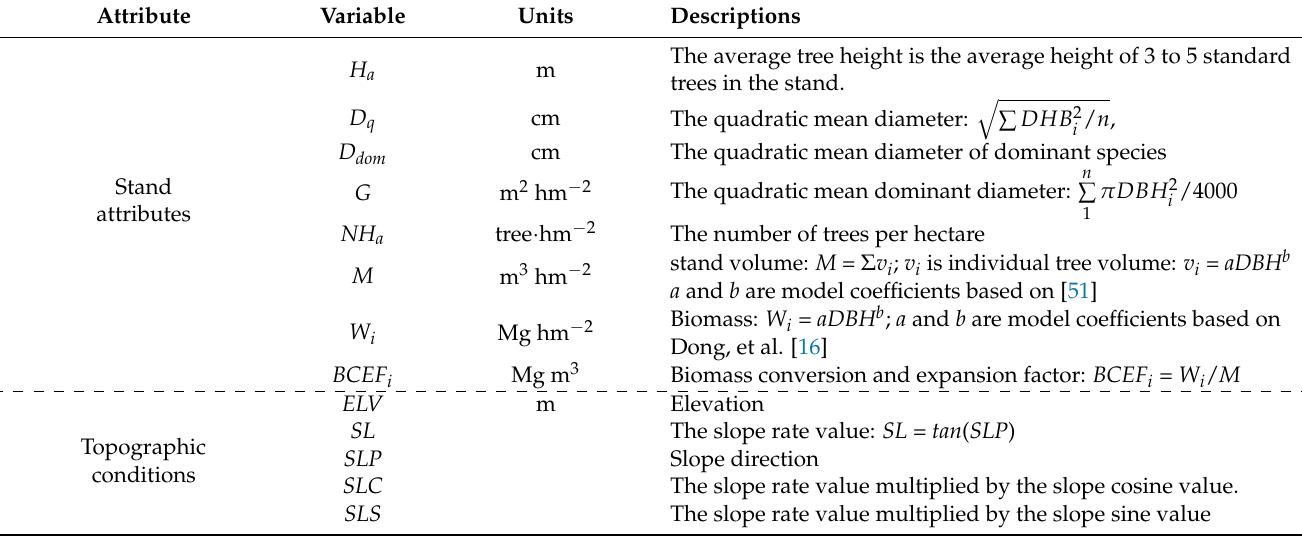
Table 1. Units and descriptions of available variables for models of biomass conversion and expansion